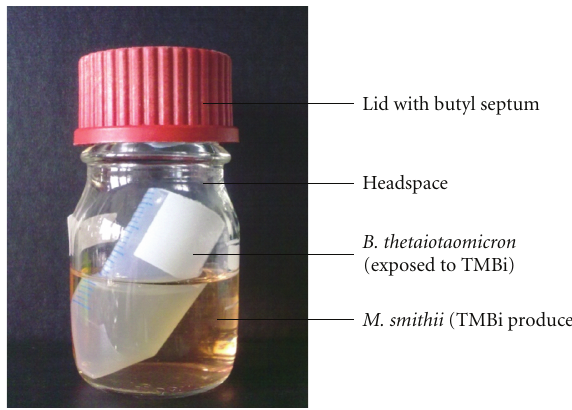
Figure 3: Design of the coculture system. The represented coculture system exhibited two separate liquid cultures under a common headspace. This design allowed the transfer of produced volatile TMBi from the culture of M. smithii to the culture of B. thetaiotao- micron over the common gas phase.